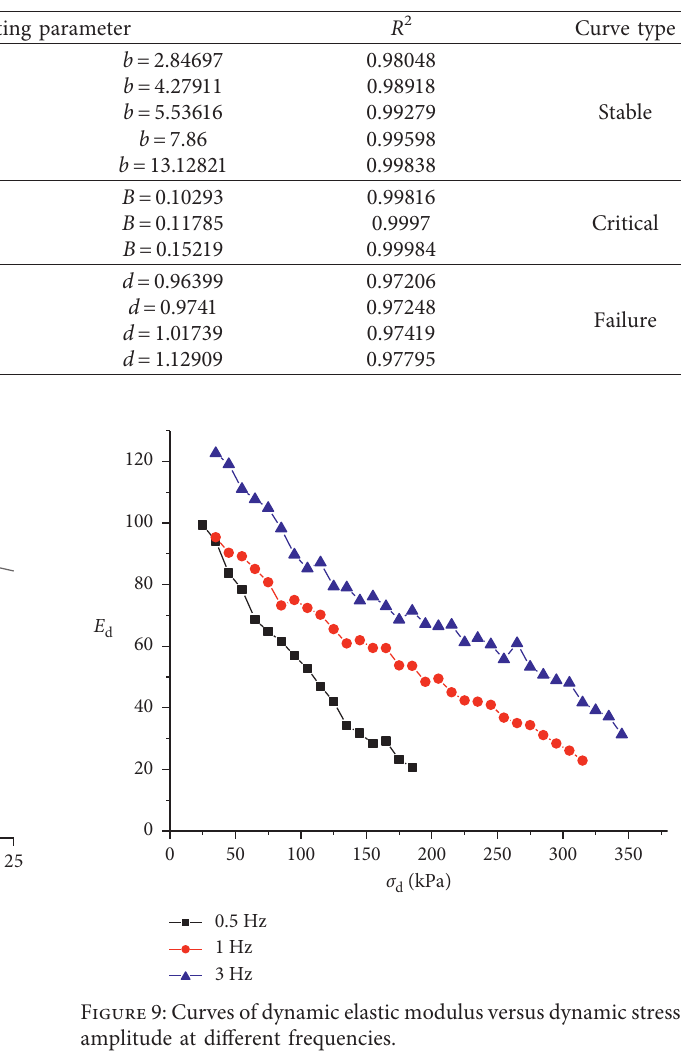
Table 3: Fitting of cumulative deformation curve with a frequency of 0.5Hz.